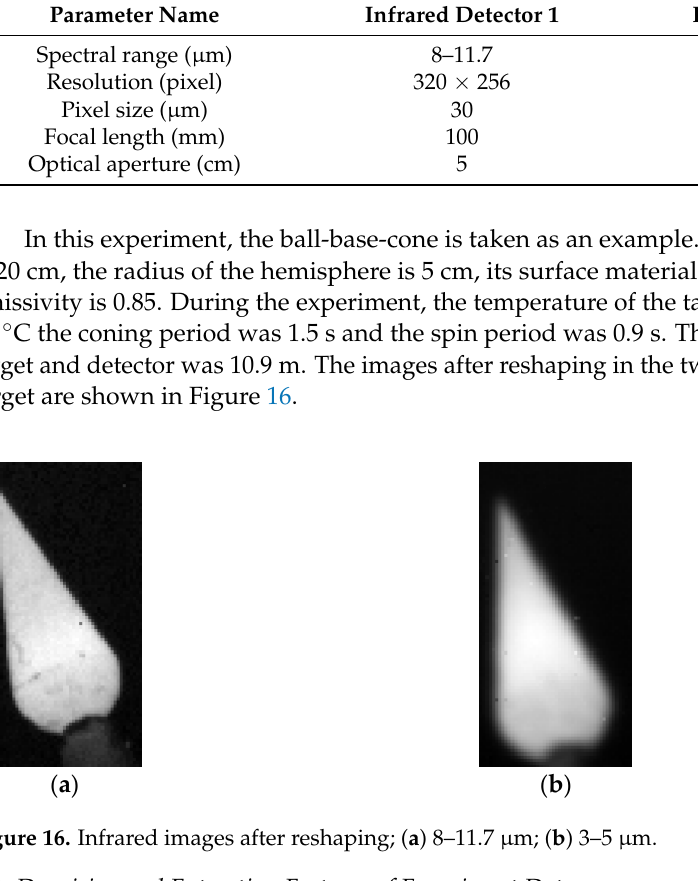
( b ) Figure 17. Radiation intensity extracting from multi-frame images; ( a ) 8–11.7 µm; ( b ) 3–5 µm. To verify the denoising effectiveness of the DA-VMD algorithm on the experimental data, different intensities of noise are added to the experimental data. Taking the radiation intensity of 8–11.7 µ m with SNR = 10 as an example, firstly, according to the mean weight FuzzDistEn, the optimal parameters of the VMD method are iteratively optimized and the combination is (K, α ) = (6, 1500). Then, decompose the noisy signal using the VMD, re- move the noise component, and reconstruct the effective signal. The resulting signal is shown in Figure 18. Compared to the other methods, the DA-VMD method eliminated the noise more accurately and maintained the changing trend of the original signal to the maximum extent. Moreover, when the SNR is 5, 10, 15, 20, and 25, the results of three evaluation indexes of different methods are shown in Figure 19. It can be seen that the proposed methods can effectively denoise and obtain the best denoising performance.